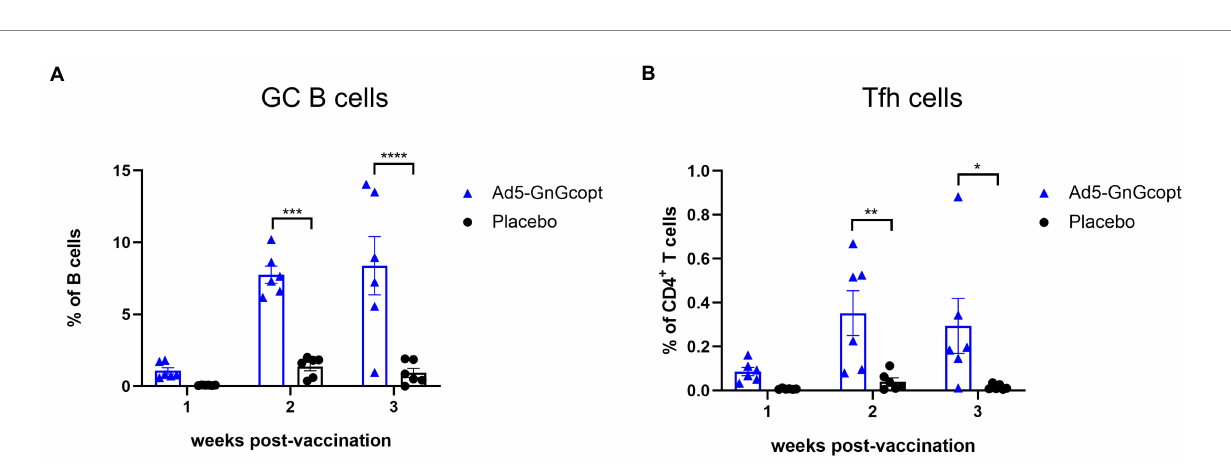
FIGURE 4 Ad5-GnGcopt efficiently stimulates strong GC B cells and Tfh cells responses. BALB/c mice ( n = 18) were immunized with a single dose of Ad5- GnGcopt (10 8 IFU) or placebo via the intramuscular route. Six mice from each group were euthanized, and the inguinal lymph nodes were collected at 1, 2, and 3 weeks after immunization. (A) The proportion of GC B cells (CD3-CD19 + GL7 + Fas + ) and (B) the frequency of Tfh cells defined as live, CD3 + CD4 + PD-1 + CXCR5 + in each group as determined using flow cytometry. Data are displayed as means ± SEM. Comparisons based on two-way ANOVA with Sidark’s multiple comparisons test with * p < 0.05, ** p < 0.01, *** p < 0.001, and **** p <